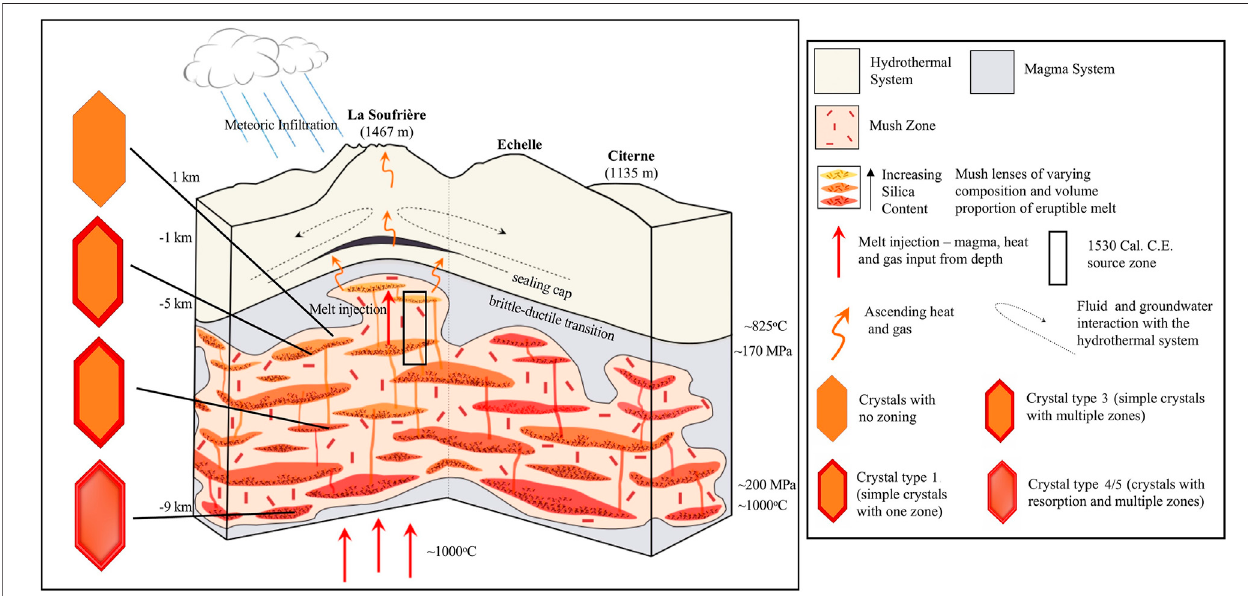
FIGURE2| SchematiccrosssectiondepictingthemushsystembeneathLaSoufrièredeGuadeloupe(adaptedfromCashmanetal.,2017;Edmondsetal.,2016; Morettietal.,2020,pressuresandtemperaturesfromPichavantetal.,2018).Basedonbulkrockcompositions,thecrystalmushzoneishypothesizedtoextendfromLa Soufrière de Guadeloupe to the Echelle and Citerne scoria cones. Basaltic magma is injected from depth into the system at temperatures ranging from 975 to 1,025 ° C (Pichavant et al., 2018), this magma interacts with the deep mush system, allowing heat and fl uids to ascend to shallow depths. Recharge events mainly affect the deep parts of the mush system, where regular magma interaction is recorded by zoning and compositional changes in the crystals. The mush system is comprised of crystal-richandmelt-richlenses.Meltcanepisodicallymoveupinthesystemleadingtomixingandamalgamation,resultinginlensesofvaryingcompositionsandcrystal populationsthroughthe system(Sparks and Cashman, 2017).Crystal and melt evolutionin themushzone creates compositionalheterogeneity. Schematic crystalsare shown with their zoning patterns and amount of resorption depending on the frequency and volume of magma interaction. Important processes occurring in the La Soufrière de Guadeloupe mush system include ma fi c recharge, magma mixing, fractional crystallization and the ascent of heat, gas and fl uids from depth into the hydrothermal system. The mush system and the extensively developed hydrothermal system allow buffering of processes that lead to eruptions, such as recharge and mixing, as shown by the 2018 period of unrest, until recharge reaches a critical threshold.